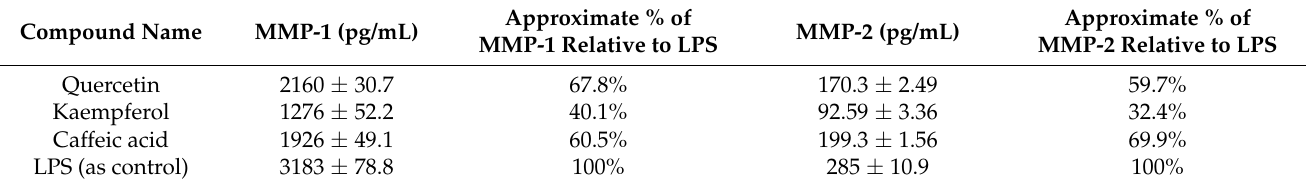
Table 4. The effects of Moringa metabolites viz. quercetin, kaempferol, and caffeic acid on matrix metalloproteinases type I and